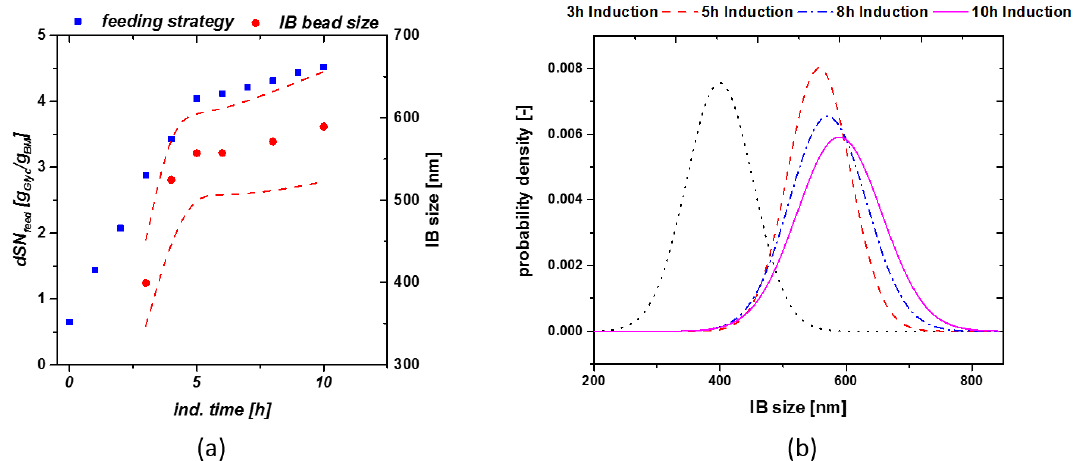
Figure 3. ( a ) Model cultivation with change in the q s,C from 0.5 g/g/h to 0.1 g/g/h at a dSn value of about 4 g/g. The lower q s,C value results in a high viable cell concentration at late induction times; ( b ) probability density plot of cultivations as a function of induction